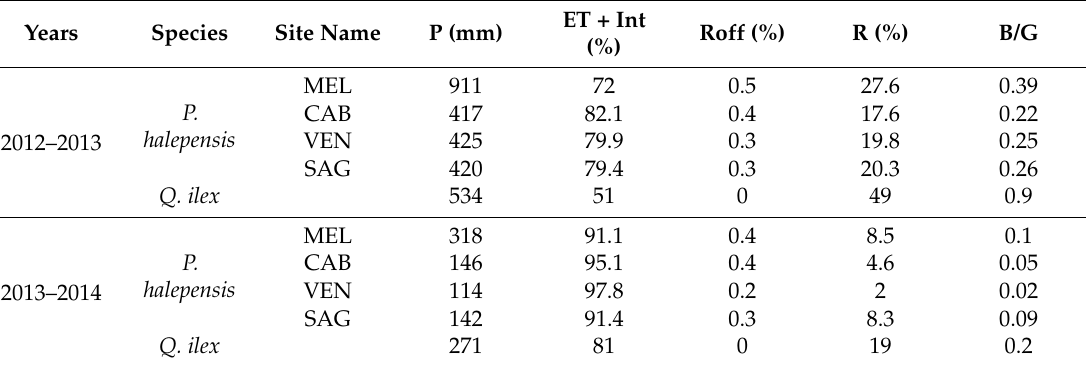
Table 2. Water balance of Pinus halepensis and Quercus ilex forests in two water years, 2012–2013 and 2013–2014, which are respectively wet and dry. P is gross precipitation, ET + Int is evapotranspiration and interception, R off is runoff, and R is potential deep drainage. B/G represents the blue to green water ratio. Adapted from Ruiz-Yanetti [49] and del Campo et al. [43]. Site names: Mela (MEL), Cabeço